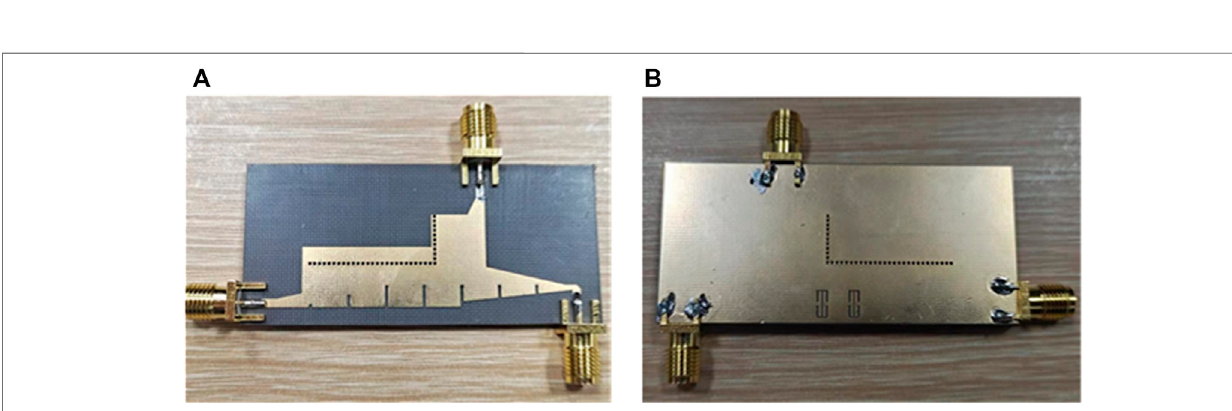
Frontiers in Physics |